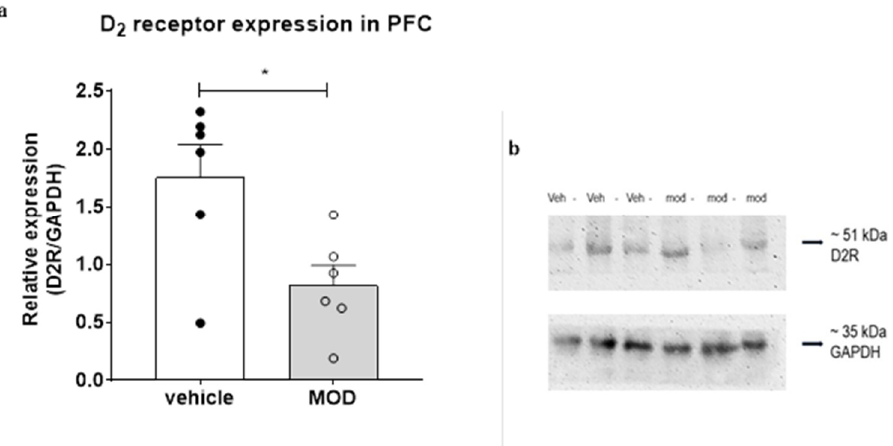
Figure 5. Dopamine type 2 receptor (D 2 ) expression in the prefrontal cortex (PFC). ( a ) D 2 expression in PFC ( b ) Examples of blots for expression of D 2 in PFC after 14 days of treatment. Vehicle and MOD groups ( n = 6), * p < 0.05; Data are expressed as mean ± SEM of arbitrary units of D 2 immunoreactivity normalized to GAPDH immunoreactivity.